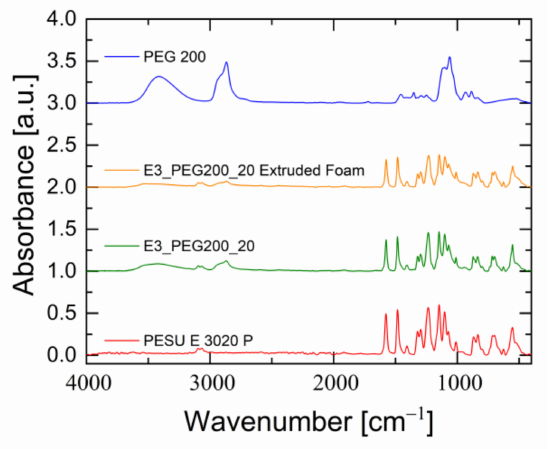
Figure 17. FTIR spectra of PESU E 3020 P, blend E3_PEG200_20, the extruded foam of blend E3_PEG200_20 and